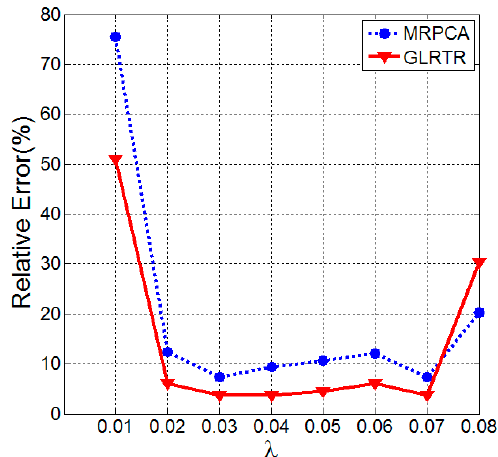
Figure 1. Comparison of relative errors between Multi-linear Robust Principal Component Analysis (MRPCA) and Generalized Low-Rank Tensor Recovery (GLRTR) with varying λ